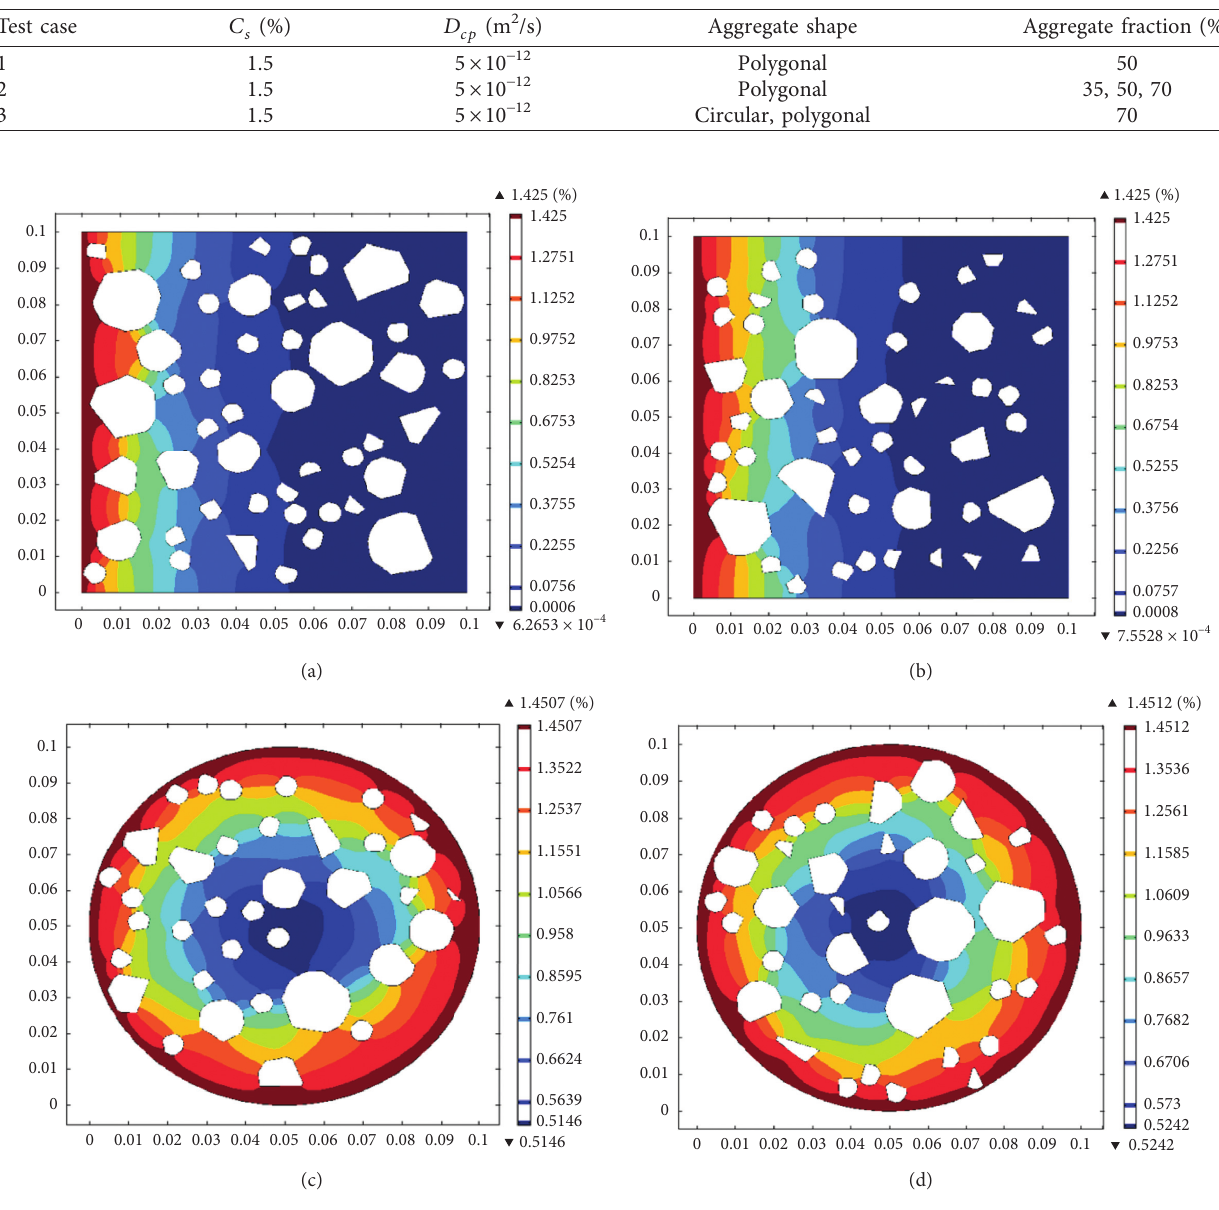
Figure 6: The distribution of chloride concentration at t � 10